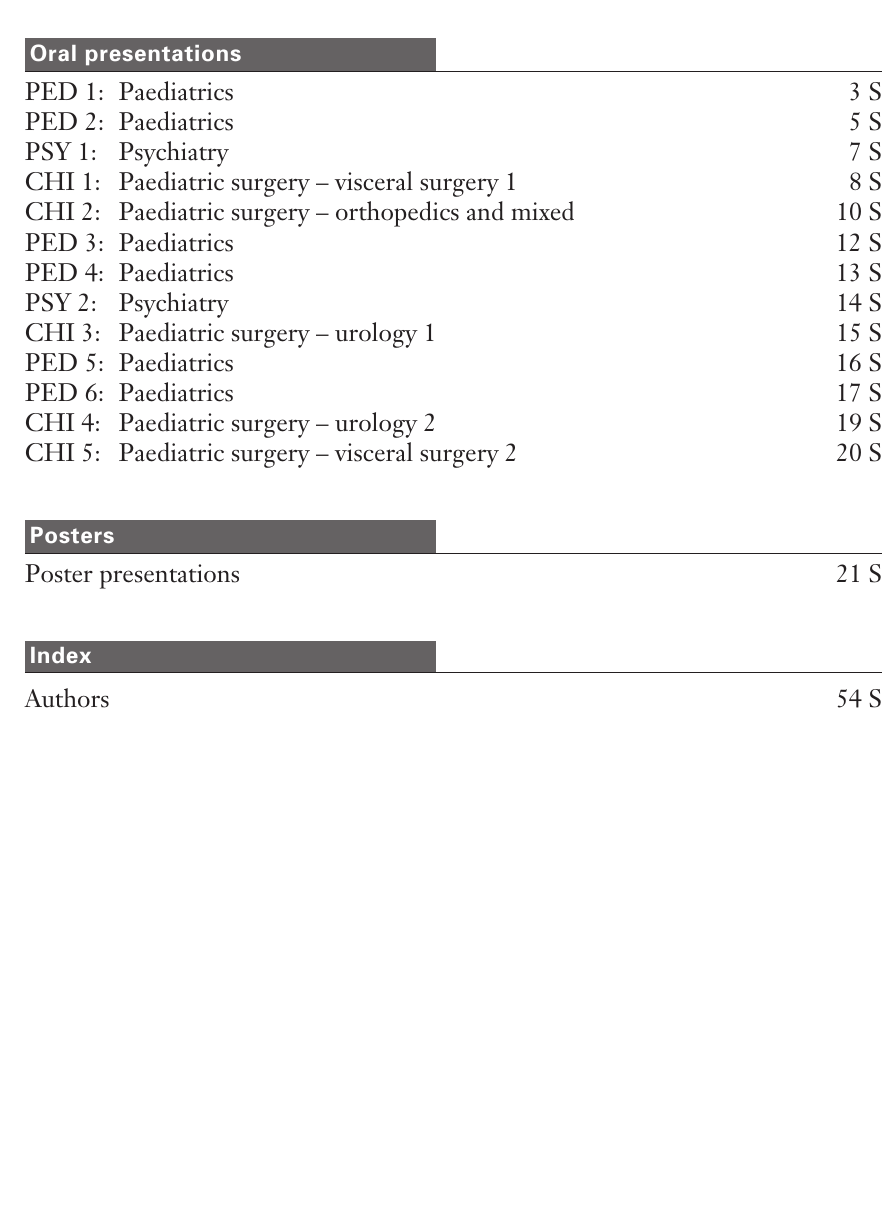
Table of contents SWISS MED WKLY 2008;138(Suppl 164) ·